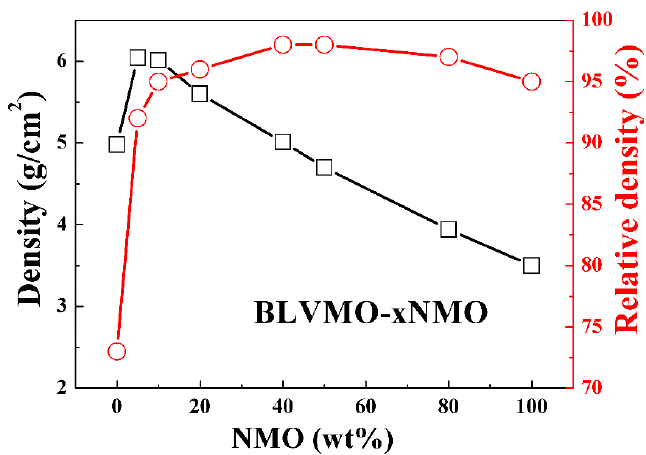
Figure 1. Bulk and relative densities of (100 − x) wt.% (Bi 0.95 Li 0.05 )(V 0.9 Mo 0.1 )O 4 (BLVMO)-x wt.% Na 2 Mo 2 O 7 (NMO) ceramic composites. Table 1. Sintering temperatures (ST), relative densities ( ρ r ), and microwave dielectric properties of